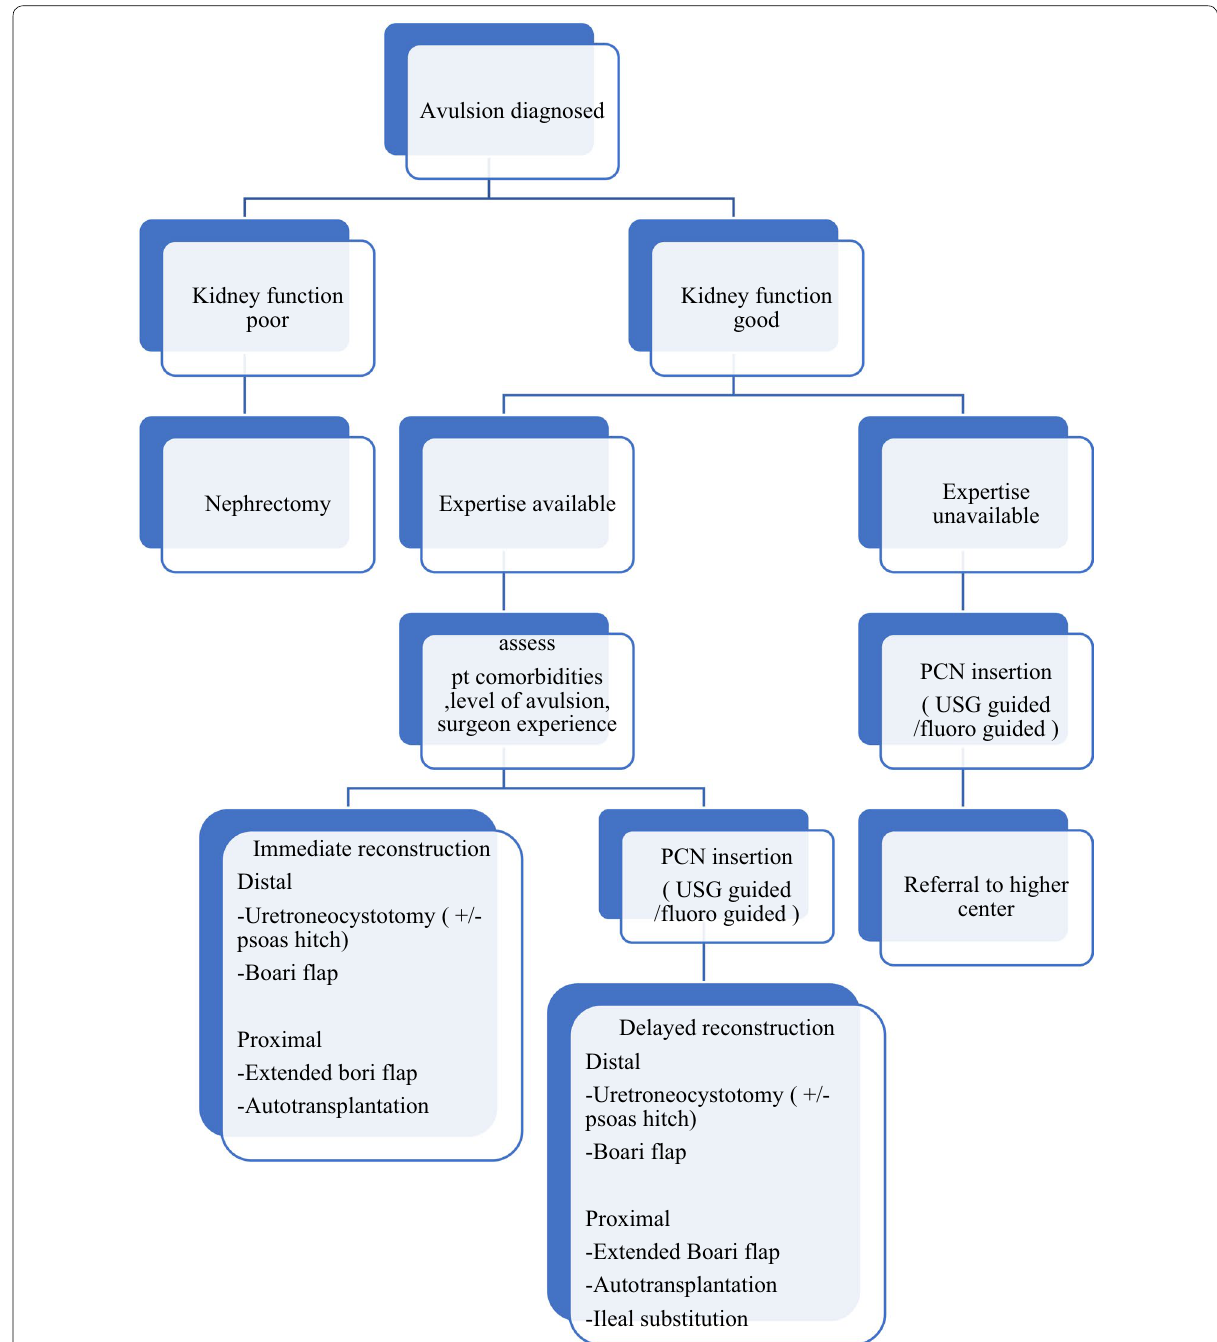
Fig. 4 Decision-making algorithm for management of ureteric avulsion during